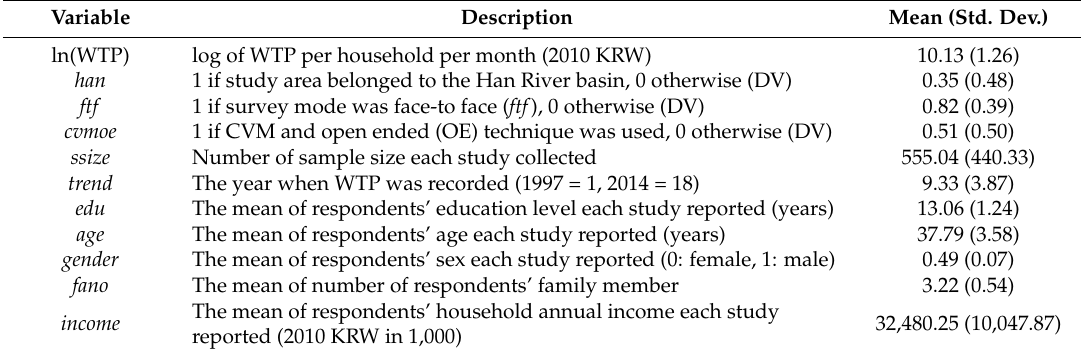
Table 2. Variable definitions and descriptive statistics of variables used in the meta-regression model.